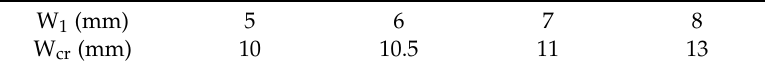
Table 1. Critical throat width of oscillators with di ff erent structures.